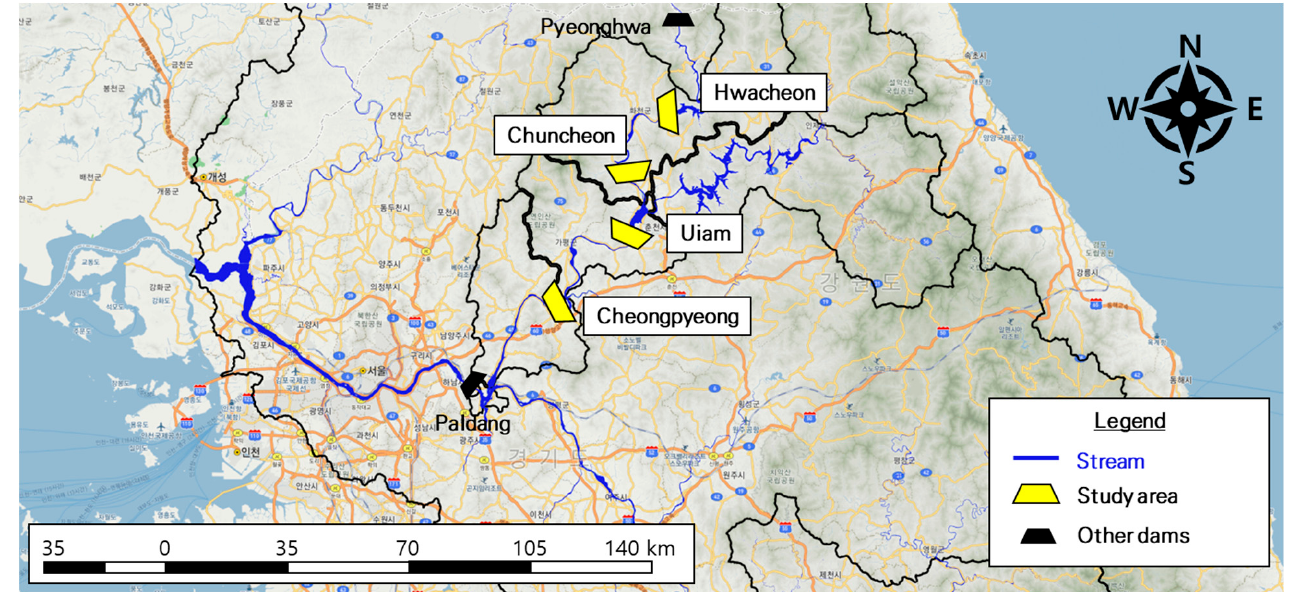
Figure 3. Study Area of Hydroelectric Dam. The trapezoidal symbols are hydroelectric dams located in the Bukhangang watershed. The yellow symbols are the target dams in this study. Pyeonghwa Dam is located at the most upstream. Table 1. The specifications of dams in study area.